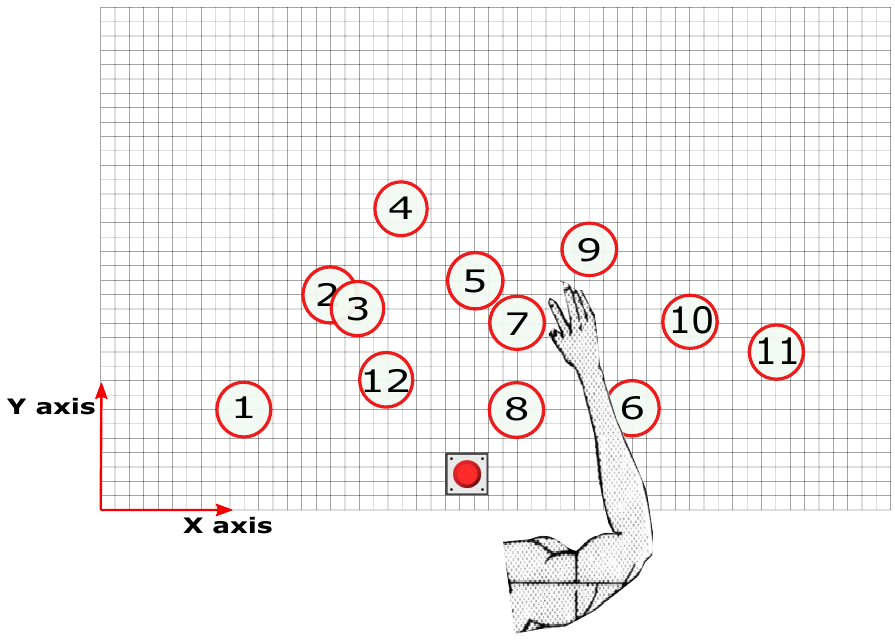
Figure 3. Schematic of the experimental table: Each red position is made up of a 4 cm radius circular. Twelve magnetic stickers are placed in different locations.